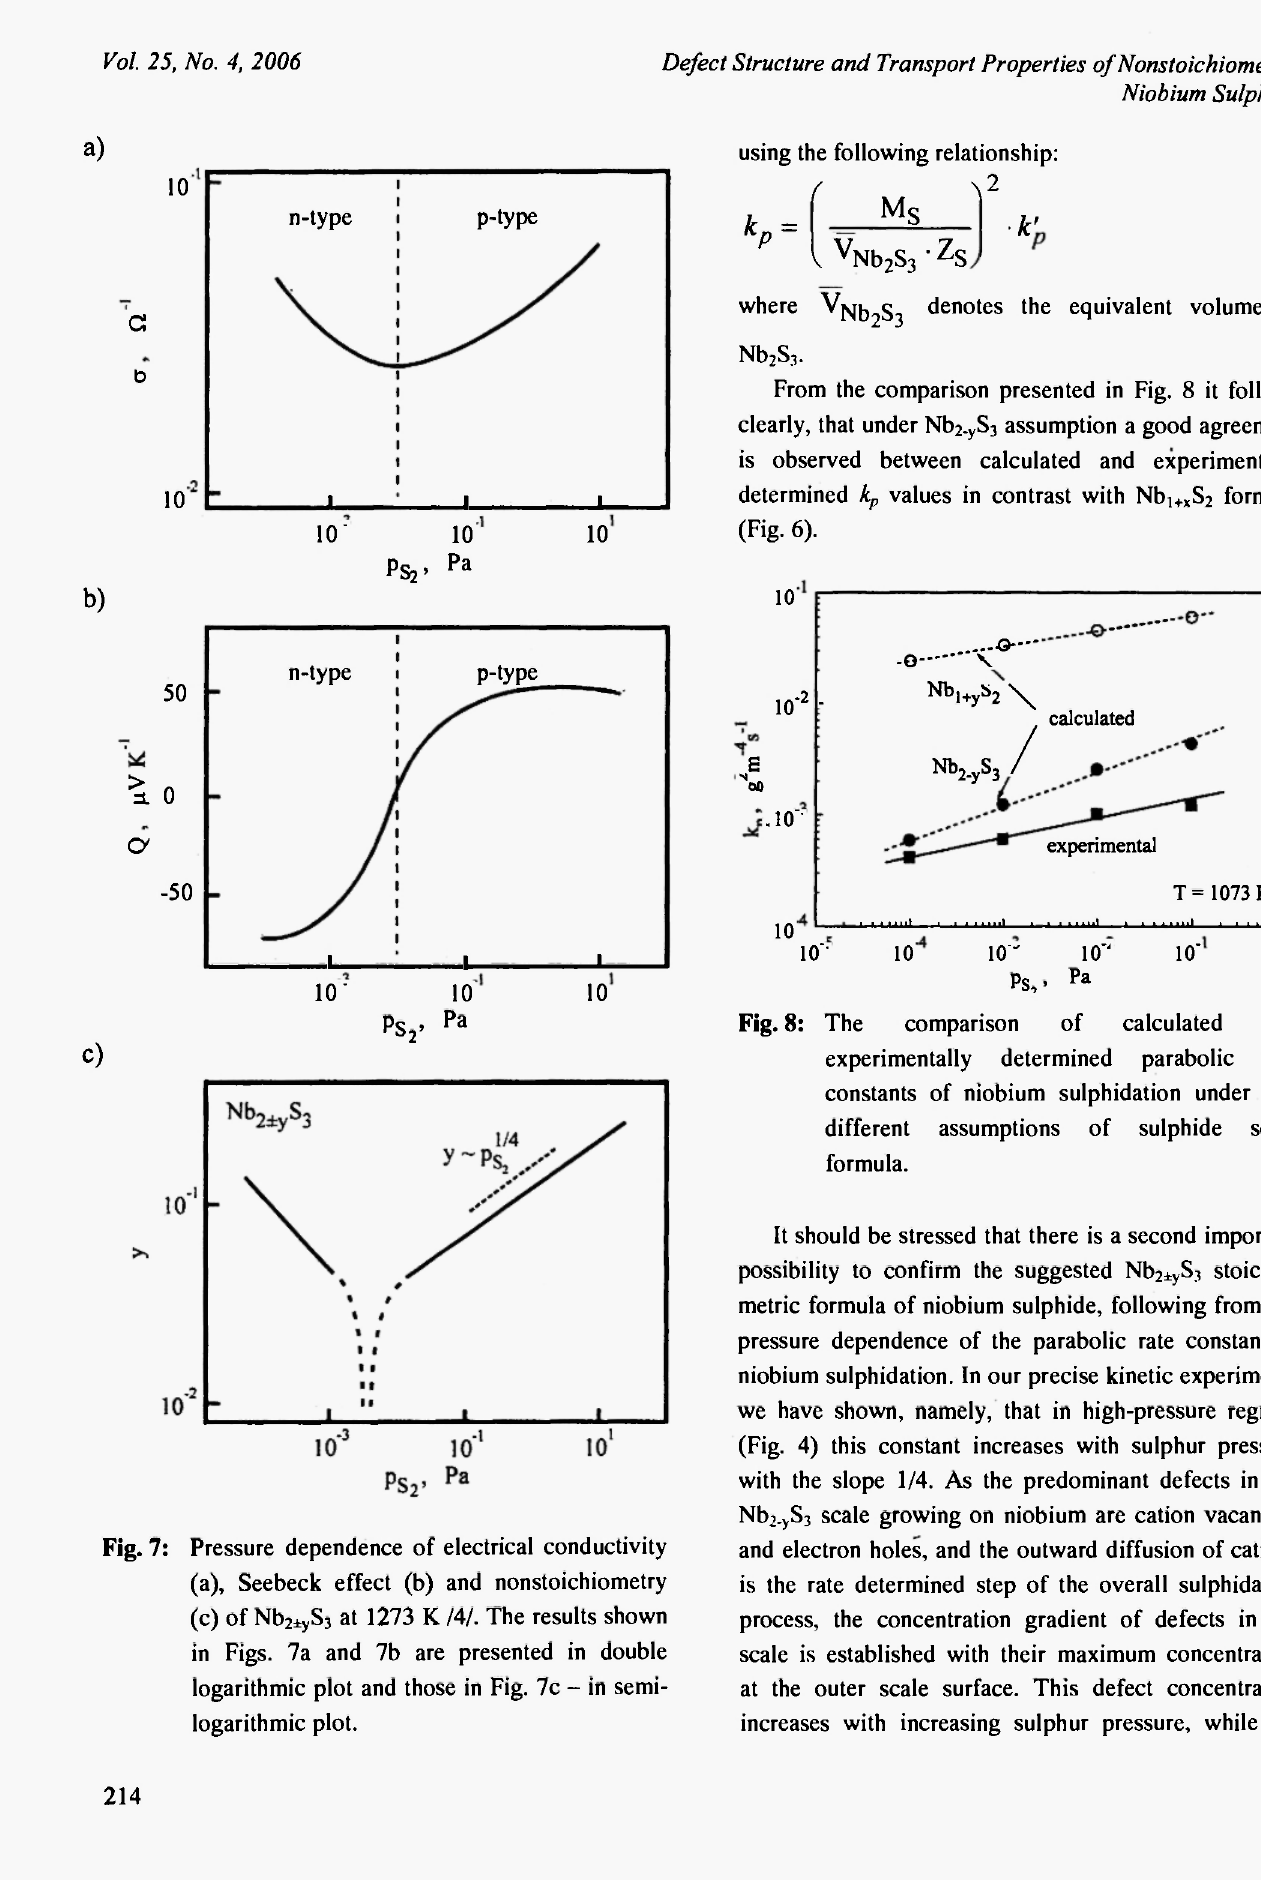
Fig. 8: The comparison of calculated and experimentally determined parabolic rate constants of niobium sulphidation under two different assumptions of scale